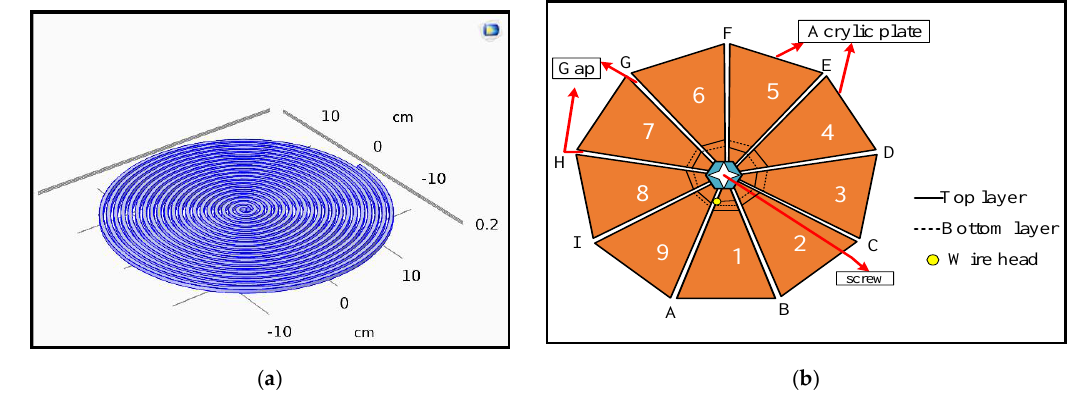
Figure 2 . A method of wrapping ( a ) spiral coil and ( b ) spider coil. Figure 2. A method of wrapping ( a ) spiral coil and ( b ) spider